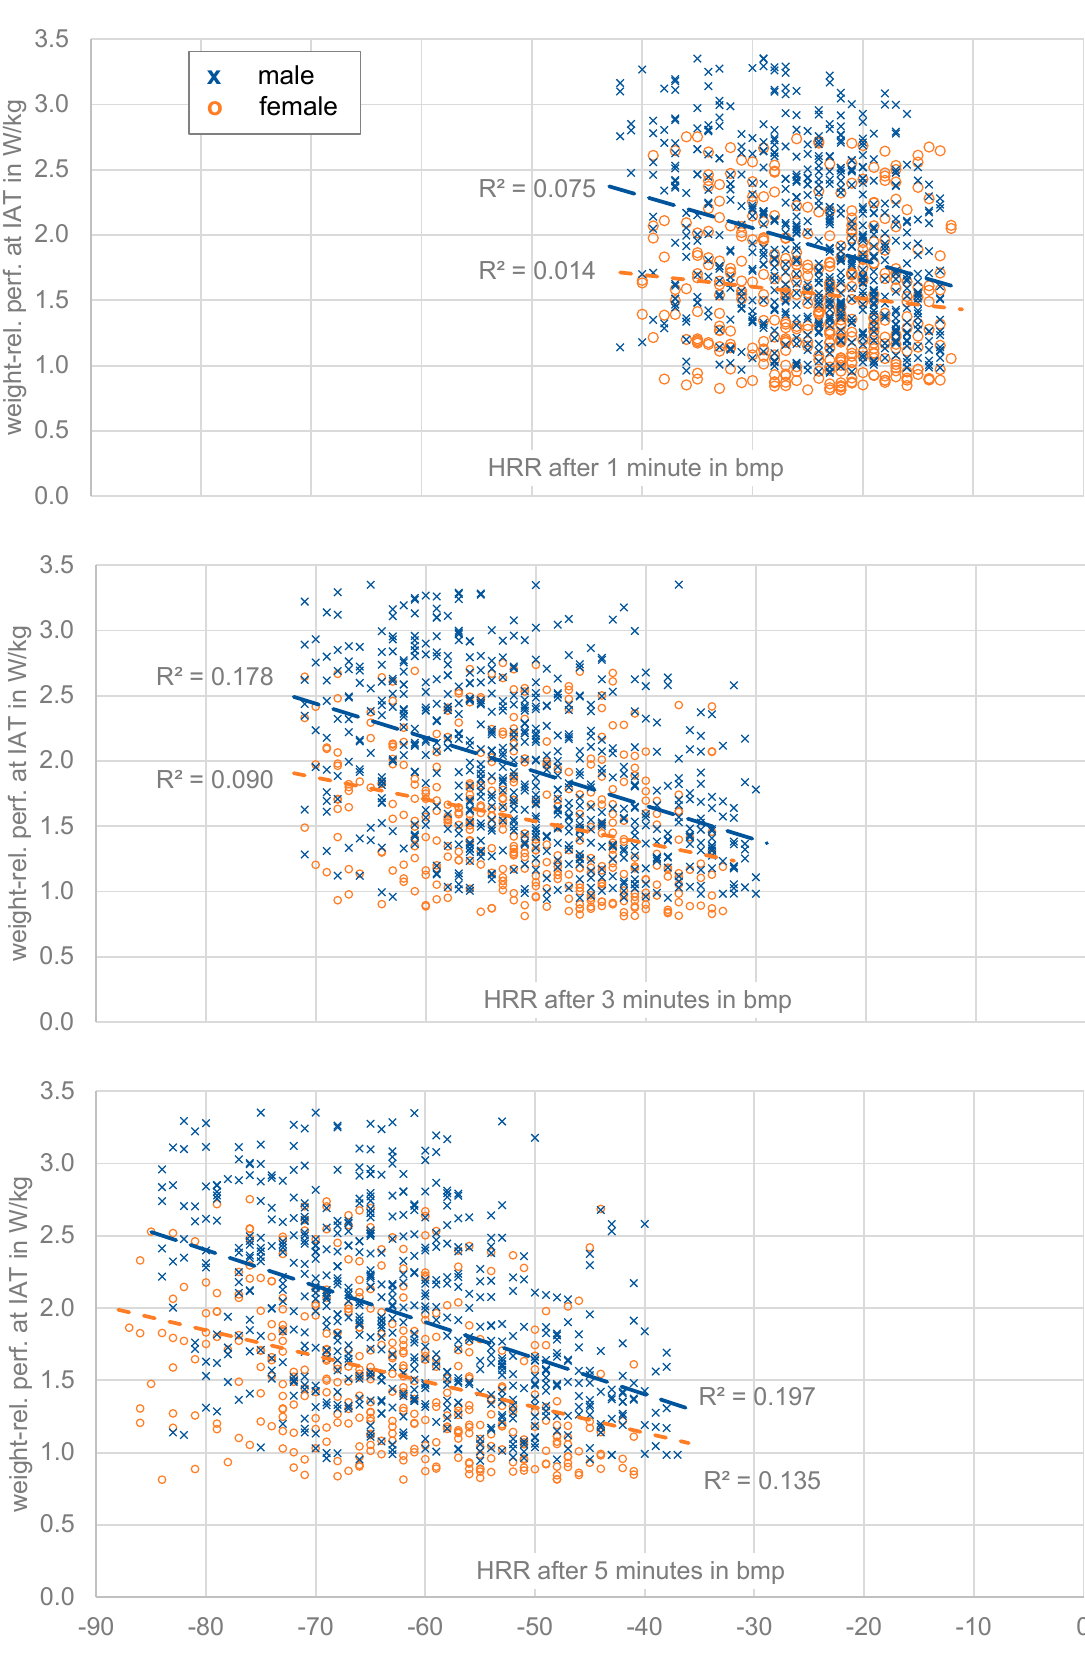
Figure 3. Weight-related performance depending on HRR after 1, 3, and 5 min for male and female athletes.